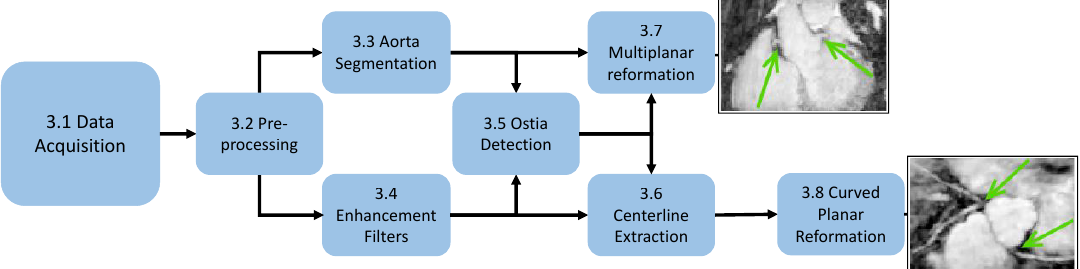
Figure 1. A schematic visualization of the processing pipeline. The numbers of the processing steps correspond to the respective